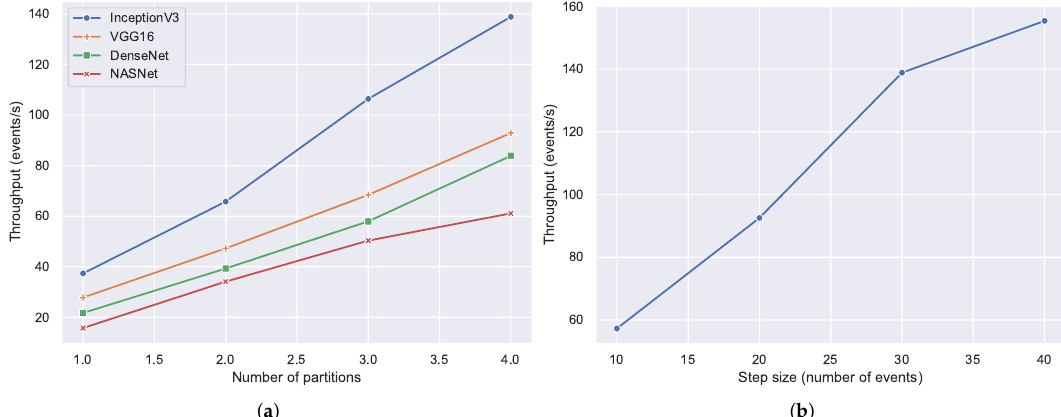
Figure 17. Throughput experiments. ( a ) Throughput of each CNN architecture with different numbers of partitions. ( b ) Throughput of InceptionV3 with different window steps.